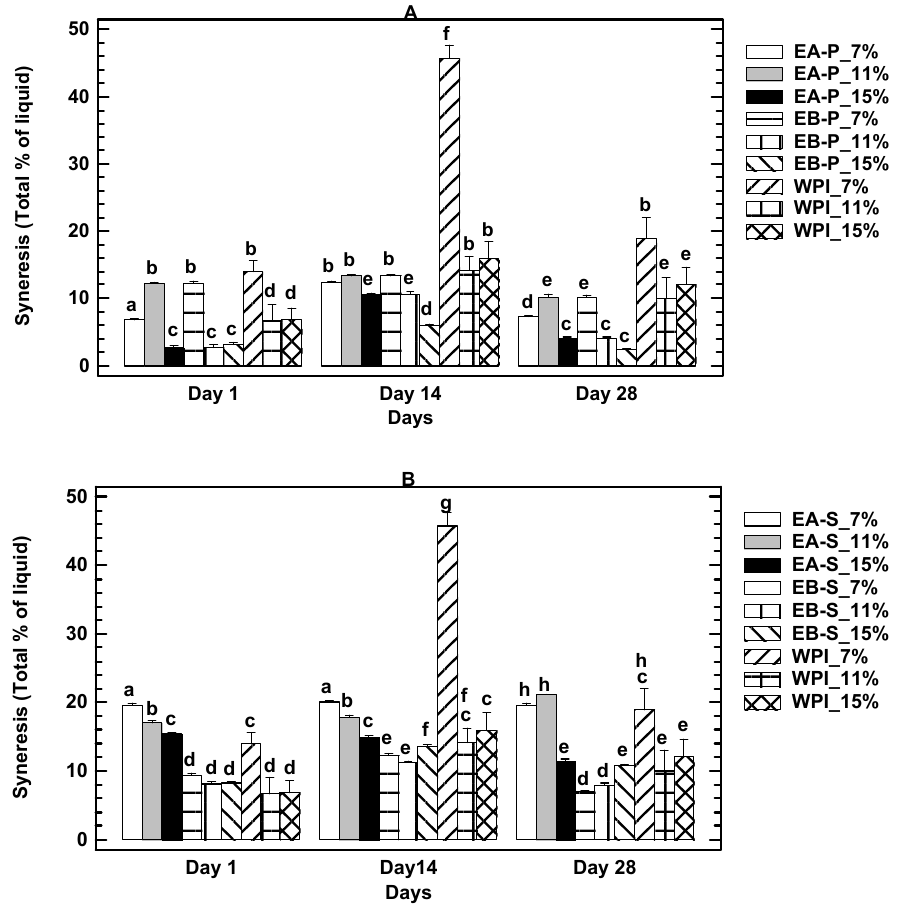
Figure 3. Syneresis after 1, 14 and 28 days of storage. ( A ) Soluble fraction ( B ) Pellet. EA = Acid Extraction, EB = Alkaline Extraction, WPI = Whey Protein Isolate. Same letter means no significant differences by figure. (Tables S3 and S4 Supplementary